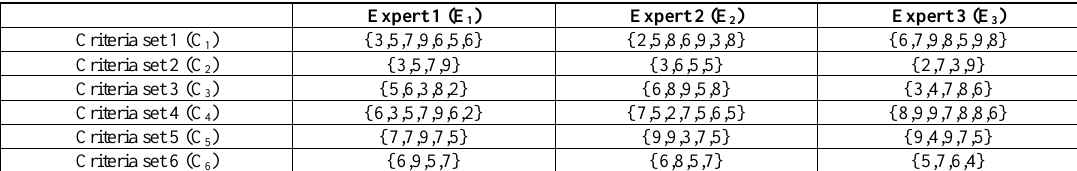
Table 2. The gathering of data from evaluation experts for criteria.